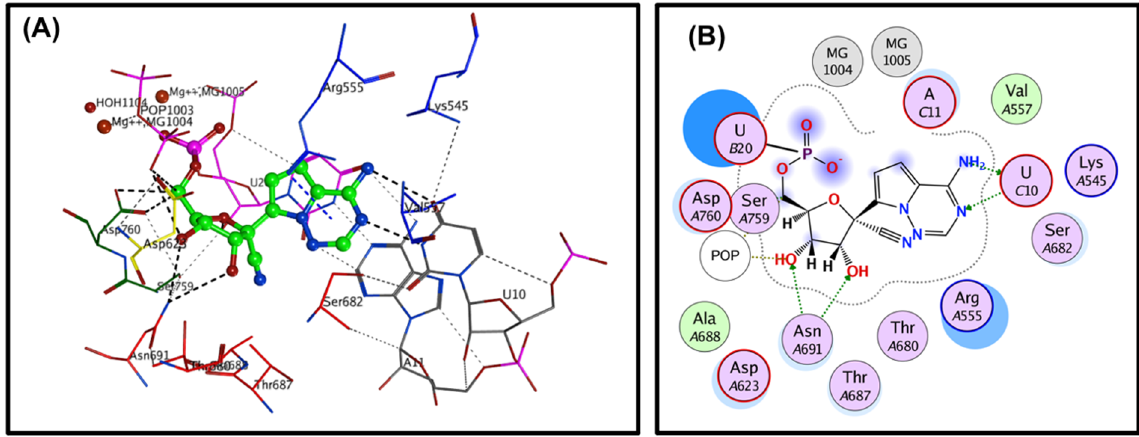
Figure 3. Structure of Remdesivir interaction with SARS-CoV2 RdRp protein. ( A ) 3D of RdRp protein interacted with Remdesivir. Green color represents the mentioned Remdesivir involved in hydrogen bonding. ( B ) 2D of RdRp protein interacted with Remdesivir.